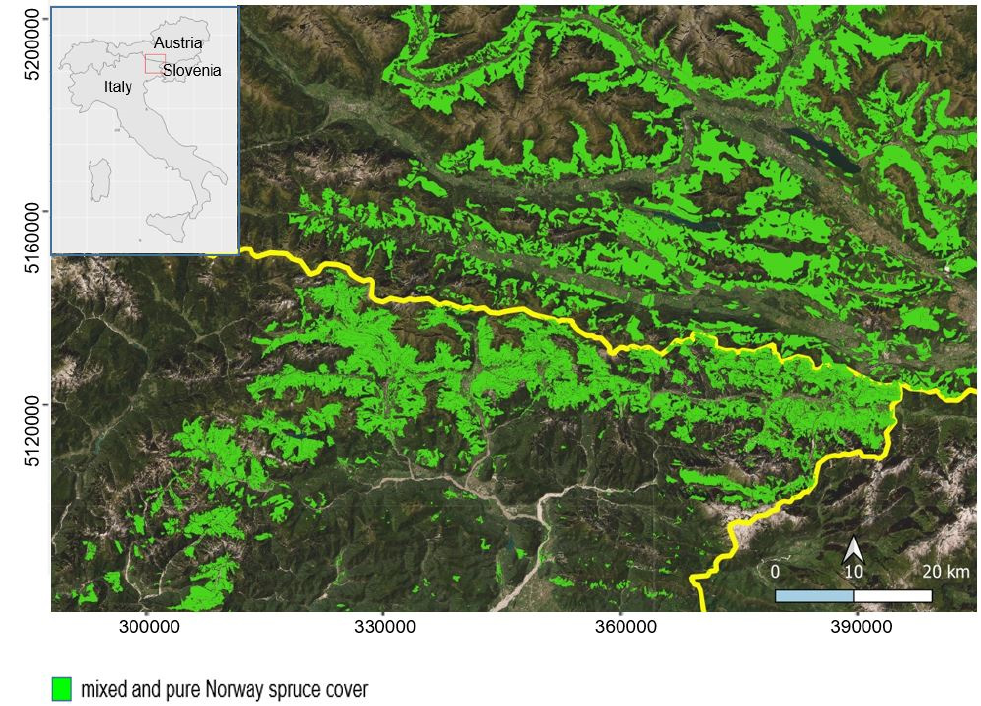
Figure 2. Location of the study area, with polygons in green representing mixed and pure Nor- way spruce stands and state borders in yellow (ESRI Satellite base map). Reference system: